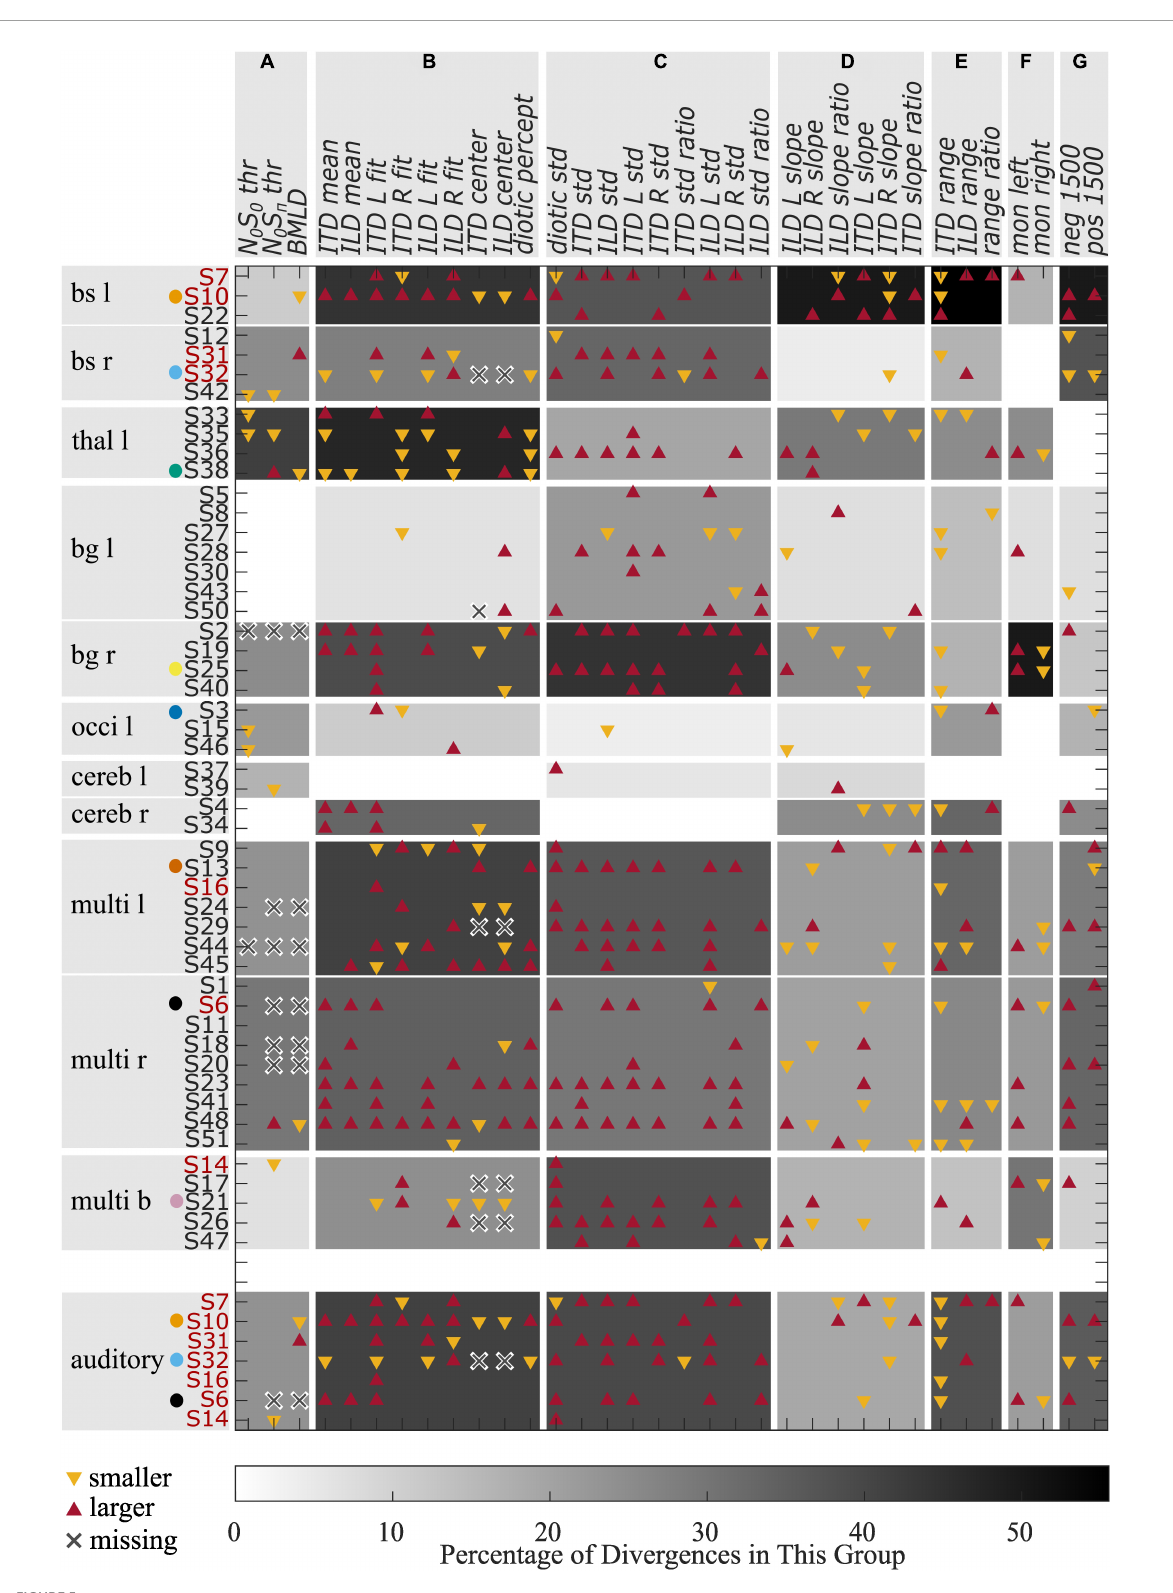
FIGURE5 Divergences from the control group for different variables. Red upward triangles indicate values of individuals that are larger and yellow downward triangles values that are smaller than the normal values (mean ± 1.5 times standard deviation) calculated from the control group. Crosses indicate missing values. The gray shading indicates the percentage of deviations found within one lesion group for one of the variable groups (A–G) . The red font is used for those patients who had a lesion on the primary auditory pathway. Selected patients are highlighted by the color coding used throughout the